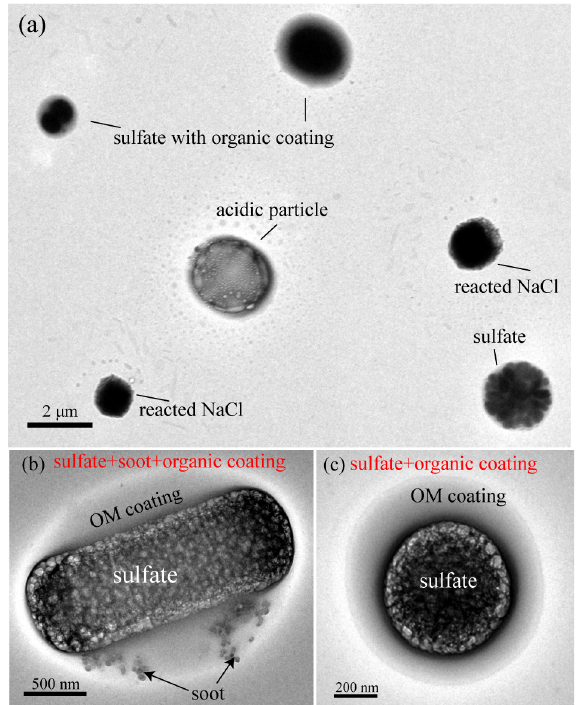
Figure 5. TEM images of individual particles containing sulfate, OM, and soot. (a) Low magnification TEM image showing sulfates, sulfate with OM coating, and reacted NaCl particles. (b) An inter- nally mixed particle of sulfate and soot with OM coating. (c) A particle with sulfate core and OM